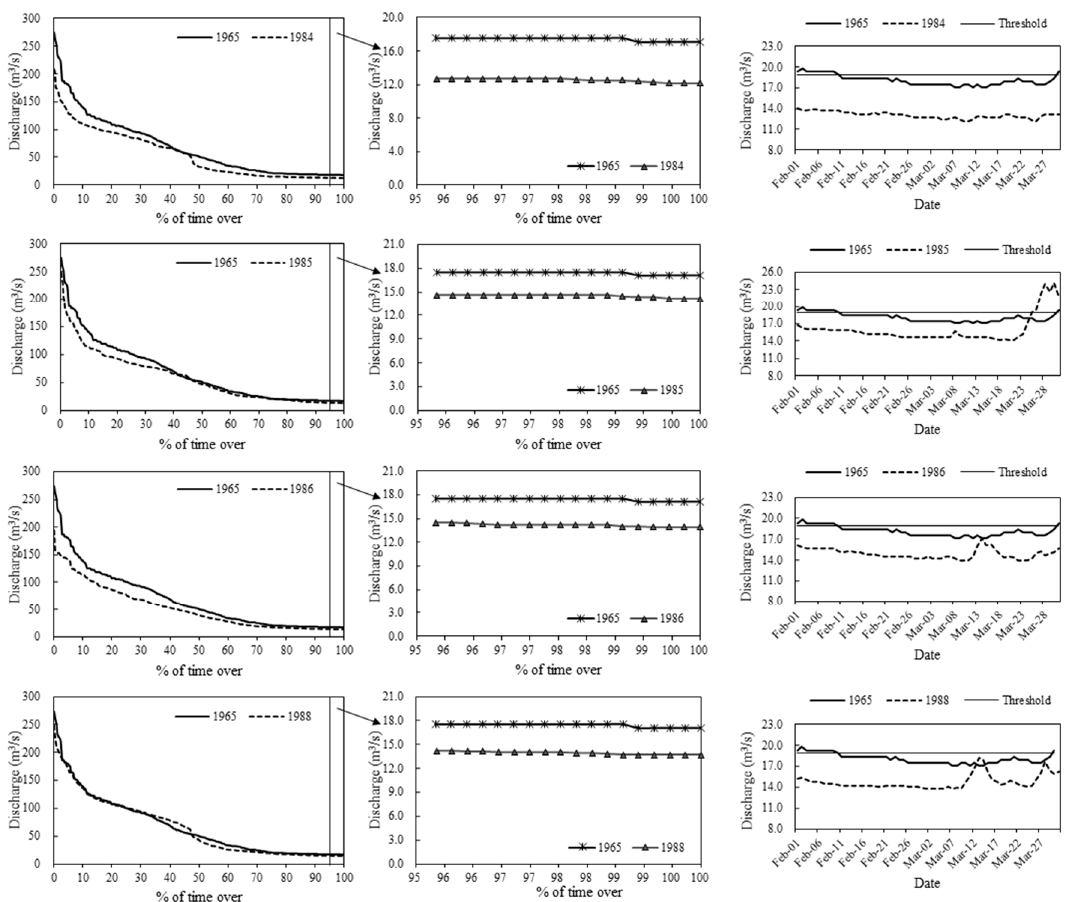
Figure A2. Flow duration curves for all selected pairs in Phase 1 and Phase 3.